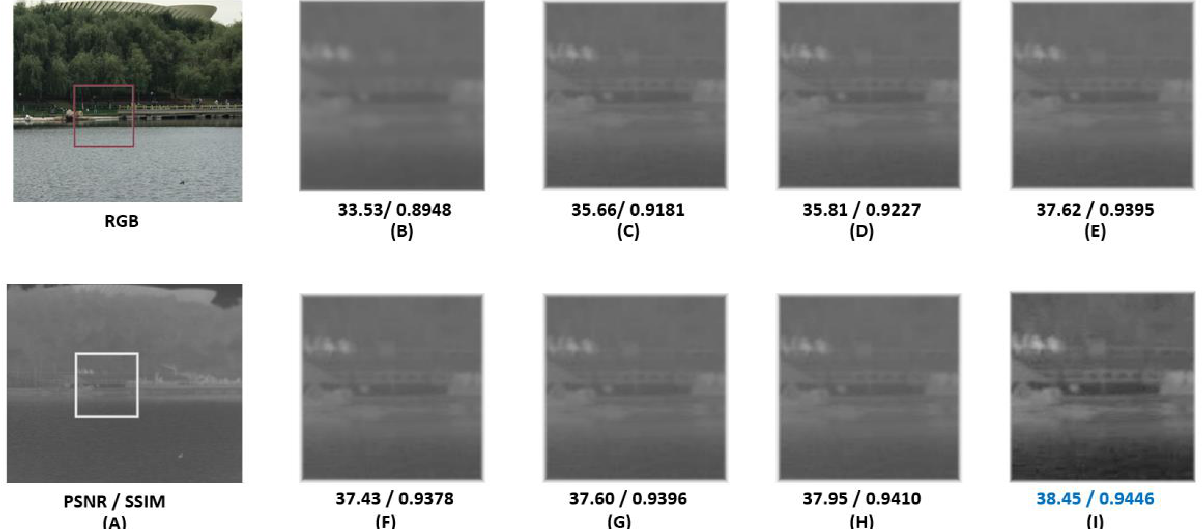
Figure 12. Comparison of restored results on bridge by different super-resolution methods (4×). ( A )